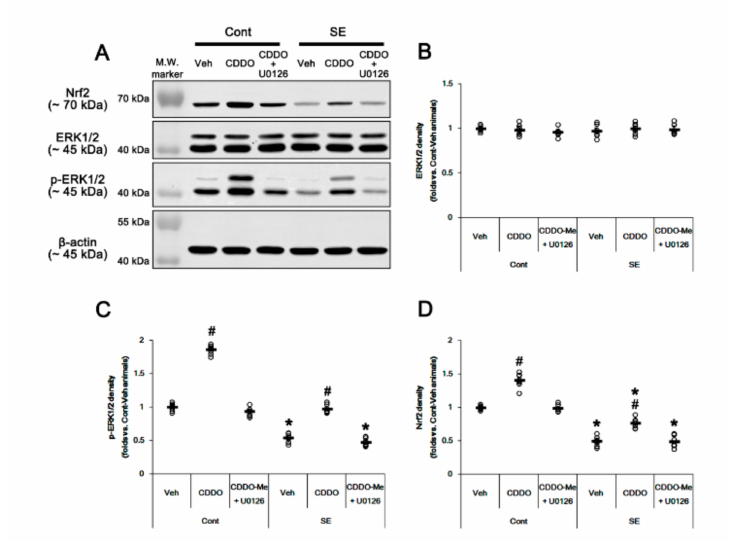
Figure 6. E ff ects of CDDO-Me and U0126 co-treatment on Nrf2 expression and ERK1 / 2 activity (phosphorylation) following SE. Under physiological conditions, CDDO-Me increases ERK1 / 2 phosphorylation and Nrf2 expression. CDDO-Me also attenuates SE-induced reductions in ERK1 / 2 phosphorylation and Nrf2 expression. U0126 co-treatment abolishes the CDDO-Me-induced upregulation of ERK1 / 2 phosphorylation and Nrf2 expression under physiological and post-SE conditions. ( A ) Representative Western blots of Nrf2, ERK1 / 2, and p-ERK1 / 2. ( B , D ) Quantification of ERK1 / 2 ( B ), p-ERK1 / 2 ( C ), and Nrf2 ( D ) levels based on Western blot data. Open circles indicate each individual value. Horizontal and vertical bars indicate mean value and S.E.M., respectively (mean ± S.E.M.; *,# p < 0.05 vs. control animals and vehicle, respectively, one-way ANOVA followed by Newman-Keuls post hoc test; n =